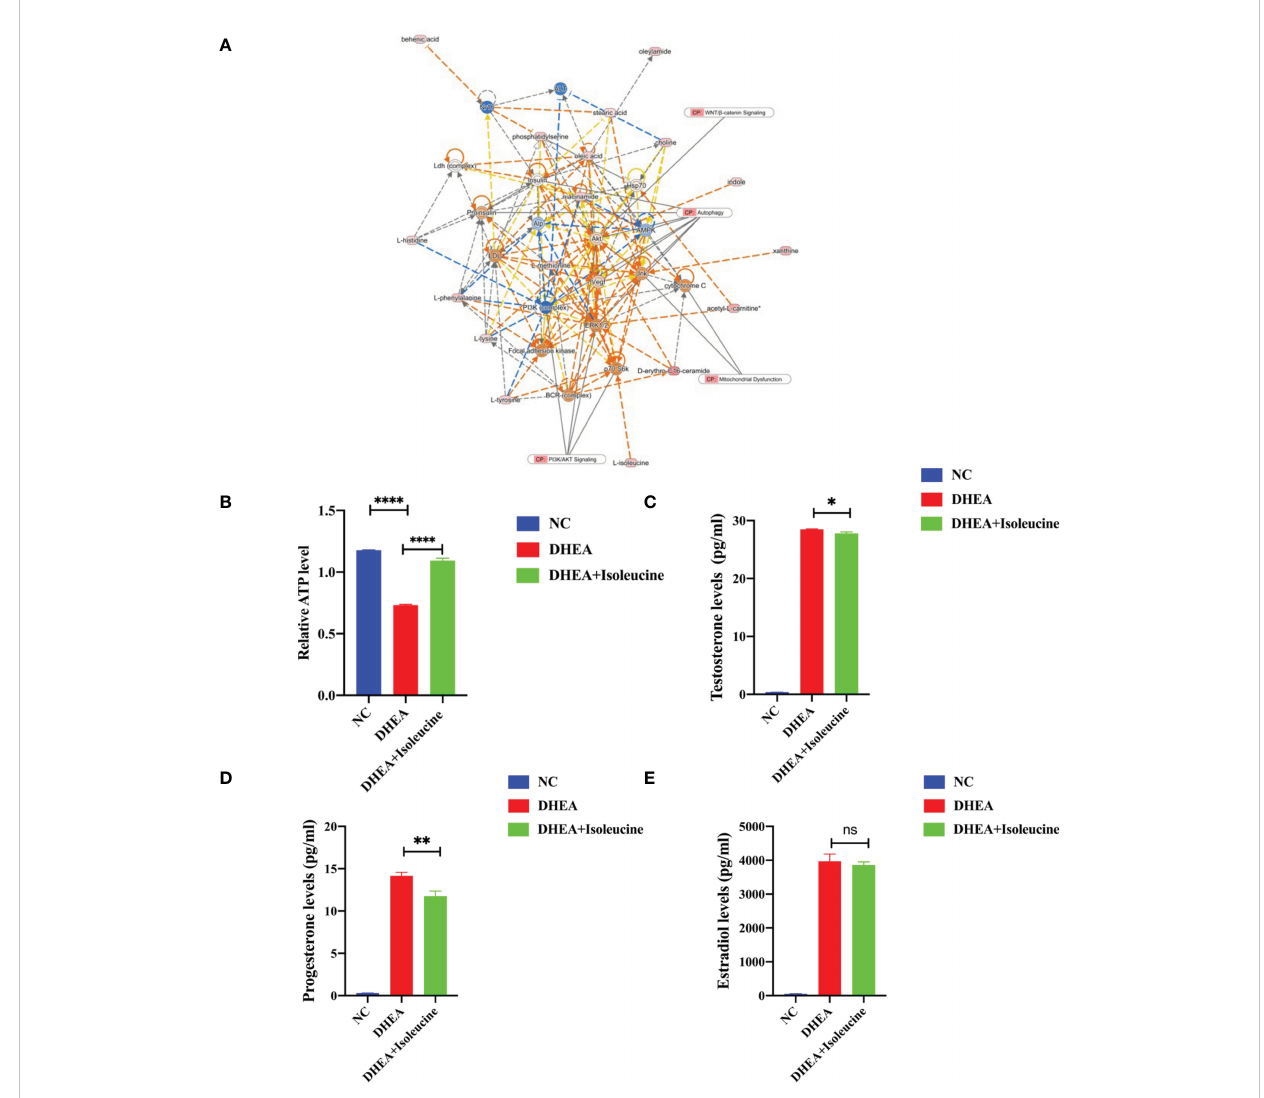
FIGURE 6 The possible mechanism of isoleucine in granulosa cells. (A) Network and function analysis of differential metabolites using the IPA database. The yellow nodes represent the upregulated metabolites. The blue nodes represent the downregulated metabolites. CP represents the signaling pathway related to the changed metabolites. (B) Relative ATP level of KGN cells transfected with DHEA (10 − 4 M) and isoleucine (20 m M). Cell serum was collected for ELISA analysis of (C) T 0 , (D) P 4 , and (E) E 2 . *p < 0.05, **p < 0.01, ****p <